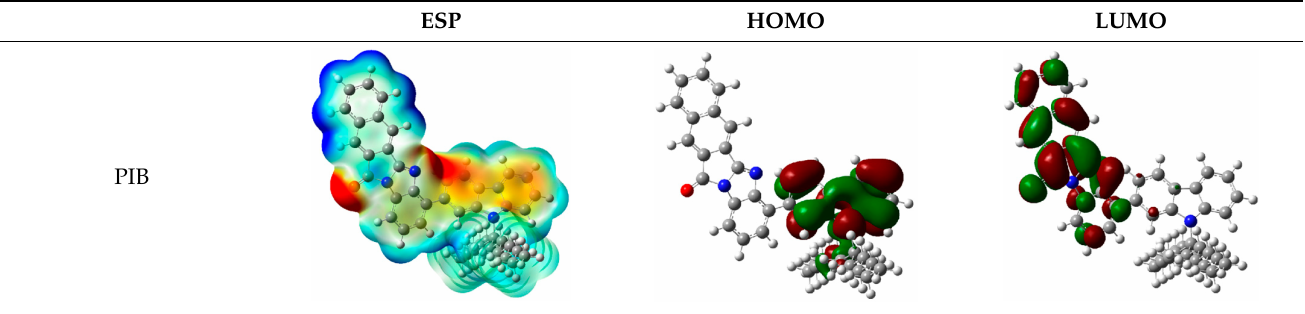
Figure S2: 13 C NMR spectrum of monomer; Figure S3: 1 H NMR spectrum of PIB; Figure S4: TGA curves of PIB; Table S1: Optical and electrochemical properties of